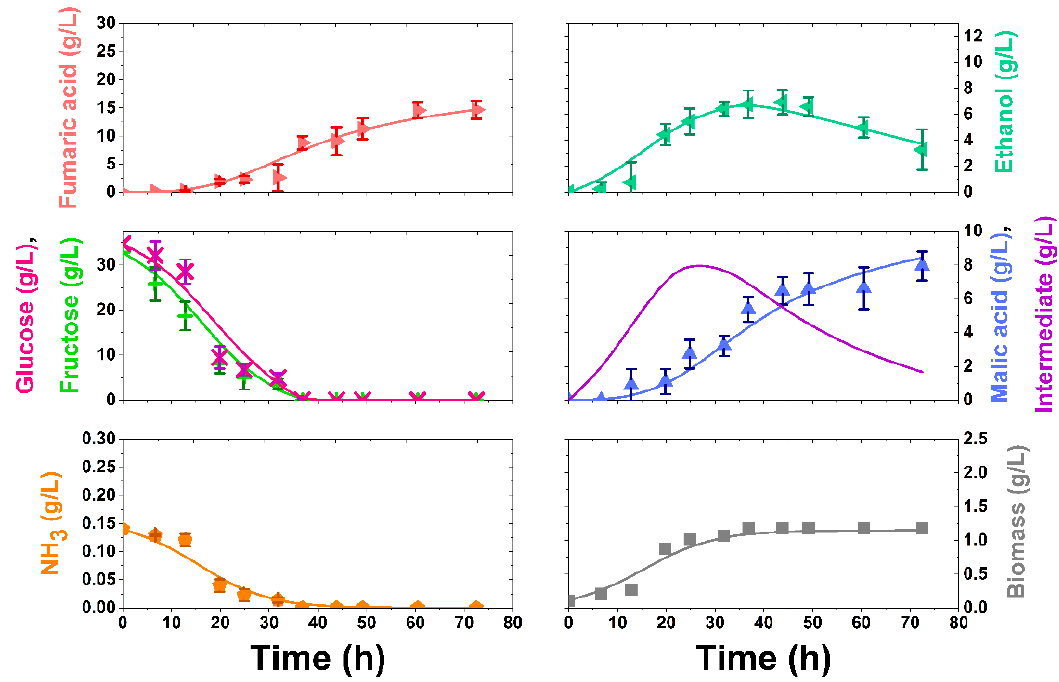
Figure 4. Experimental results (points) and simulation (lines) by means of the kinetic modelling applied on Experiment 3 (APH, [NH 3 ] 0 = 0.14 g/L, 200 rpm, 34 °C).